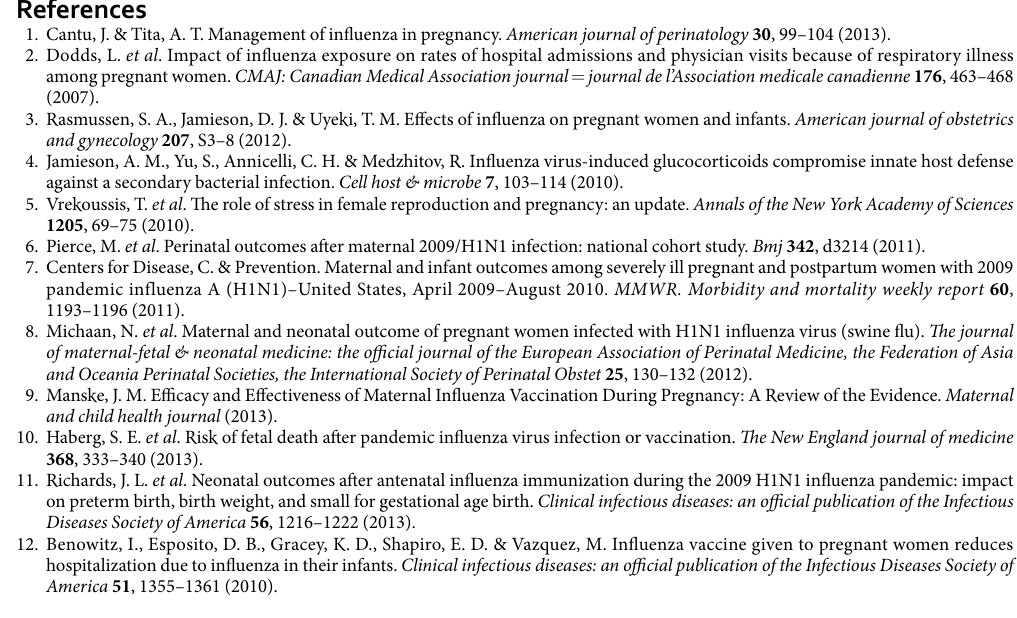
Pipersville, PA) WHO protocol 49, 54 . Sera from vaccinated mice was heat inactivated and neutralizing potency was determined in a microneutralization assay using 100 TCID 50 /well of H1N1 A/Brisbane/59/07 virus 17 . Challenge studies of adult and young mice.